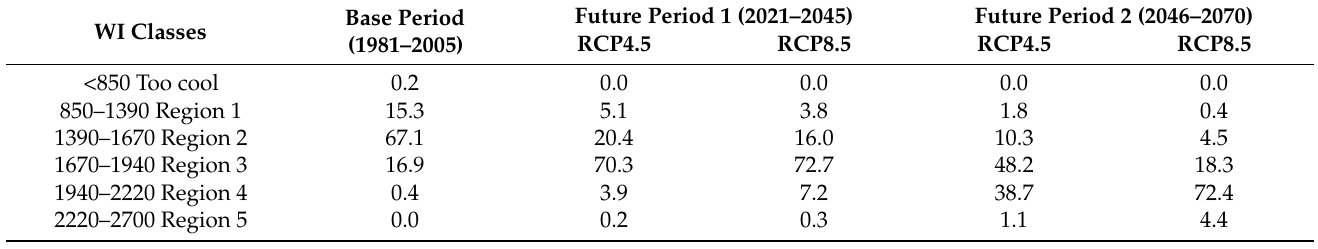
Table 3. Area (%) corresponding to various classes of the Winkler index for the Sevastopol region for two future periods under different RCP.